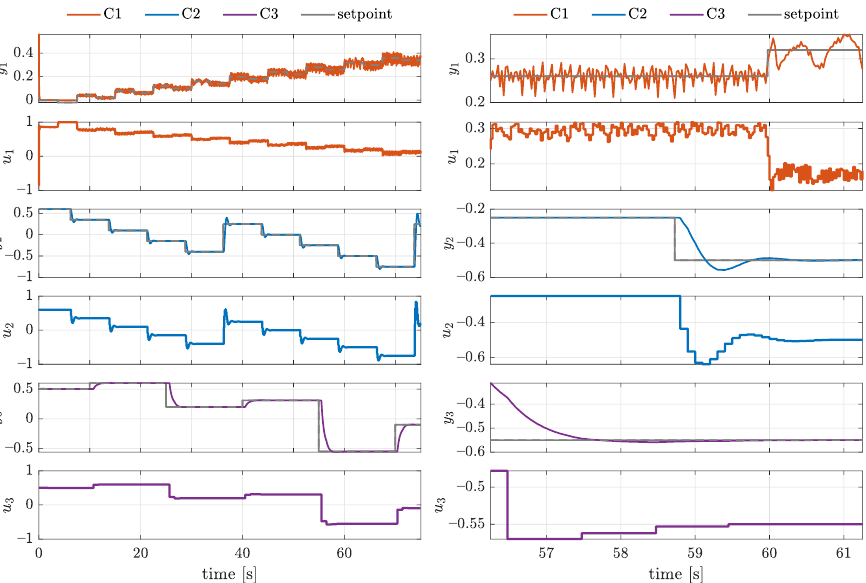
Figure 15. Results of experiment conducted with the servomotor and simulated on FPGA processes, with a sampling period of 25ms: full experiment ( left ) and zoomed ( right